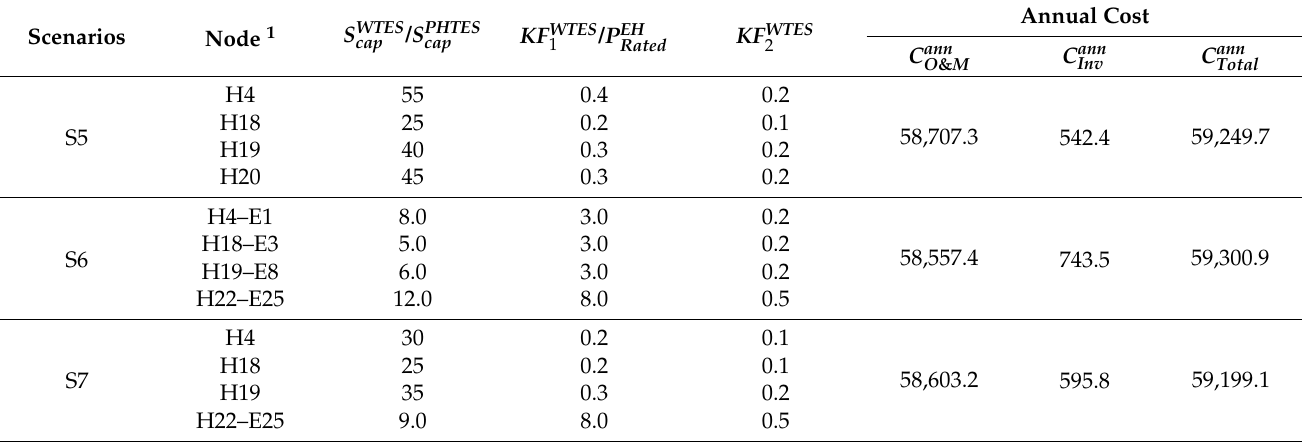
Table 5. Optimization results of configuration schemes of S5–S7.